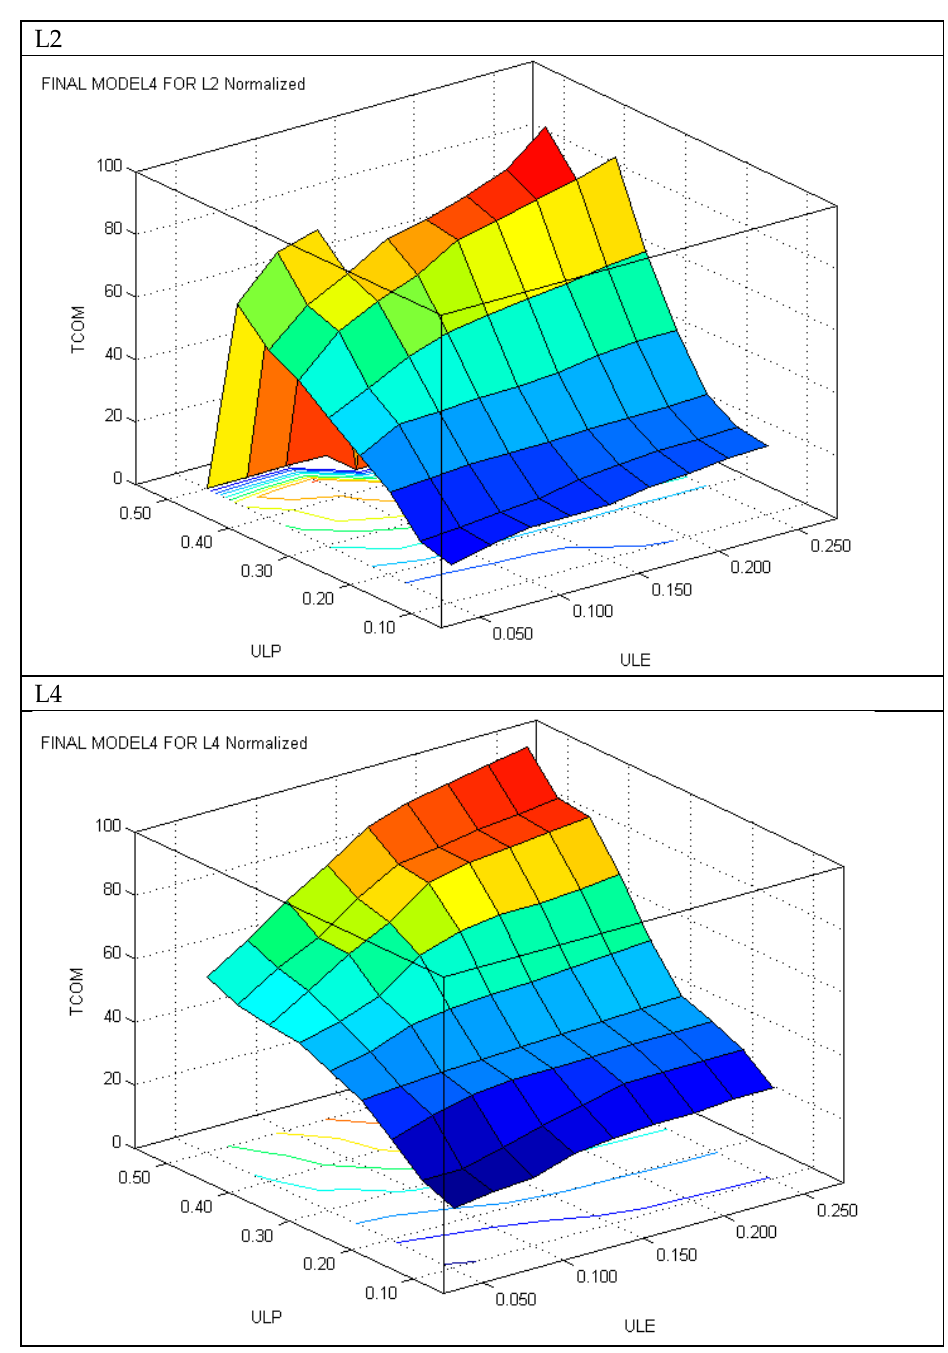
Figure 10. Commuting Cost Surface.